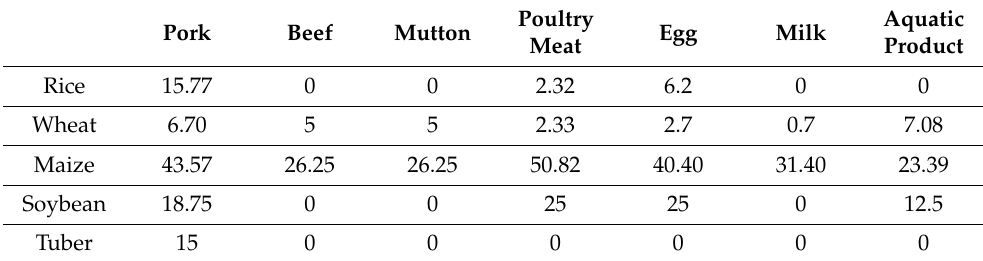
Table 2. Ratio of different types of grain needed in different forage, unit: